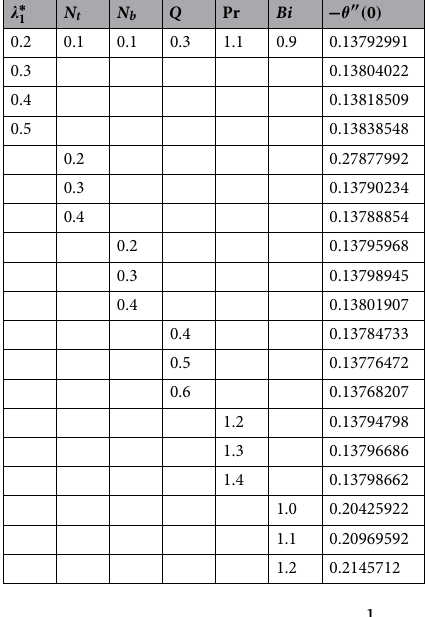
Table 2. Numerical estimation of Nu x R